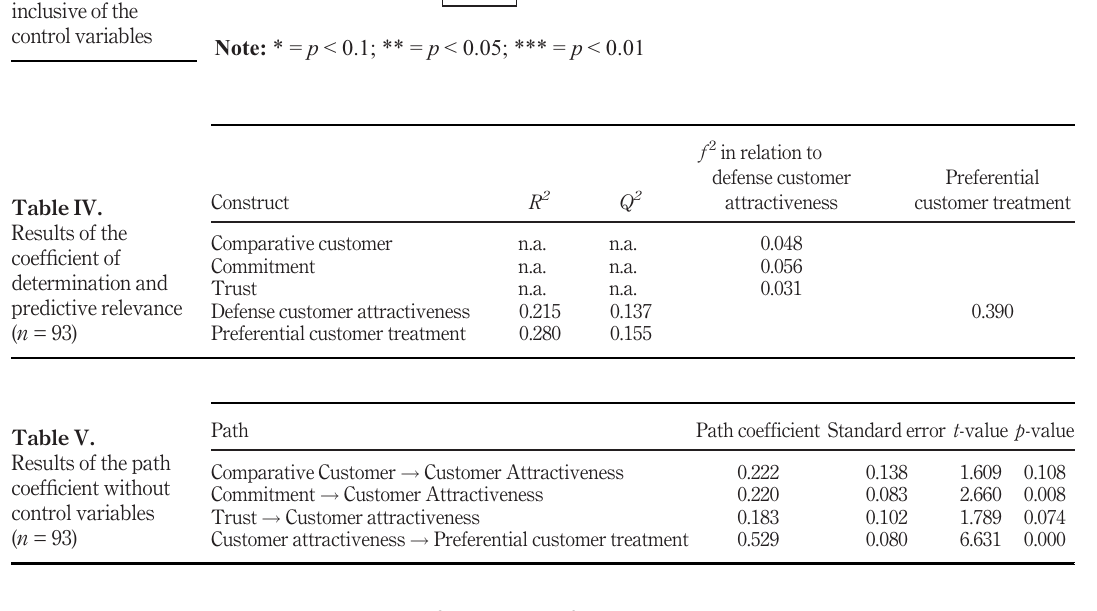
customer treatment ( R 2 = 0.280; Q 2 = 0.155) indicate that the model has moderate explanatory power.